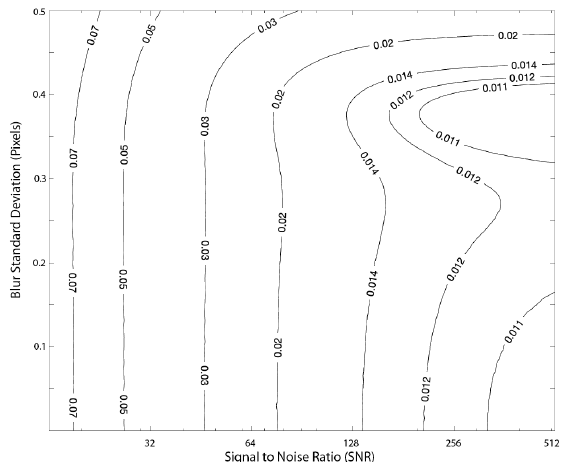
Figure 8. Contours of streak localization error (in pixels, assuming a 5 our method as a function of SNR and blur. Error statistics are computed from a Monte Carlo analysis consisting of 5000 randomized images at each SNR and blur